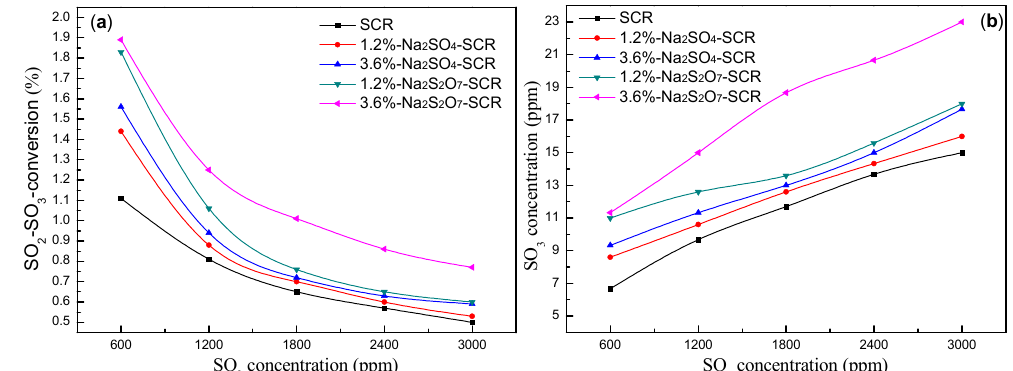
Figure 2. Effect of SO 2 concentration on ( a ) SO 2 –SO 3 -conversion and ( b ) SO 3 concentration. Reaction conditions: T = 350 ◦ C, 5% O 2 , 500 ppm NO, 500 ppm NH 3 , 2% H 2 O, total flow gas 1.5 L/min, and gas hourly space velocity (GHSV) = 45,000 h − 1 .